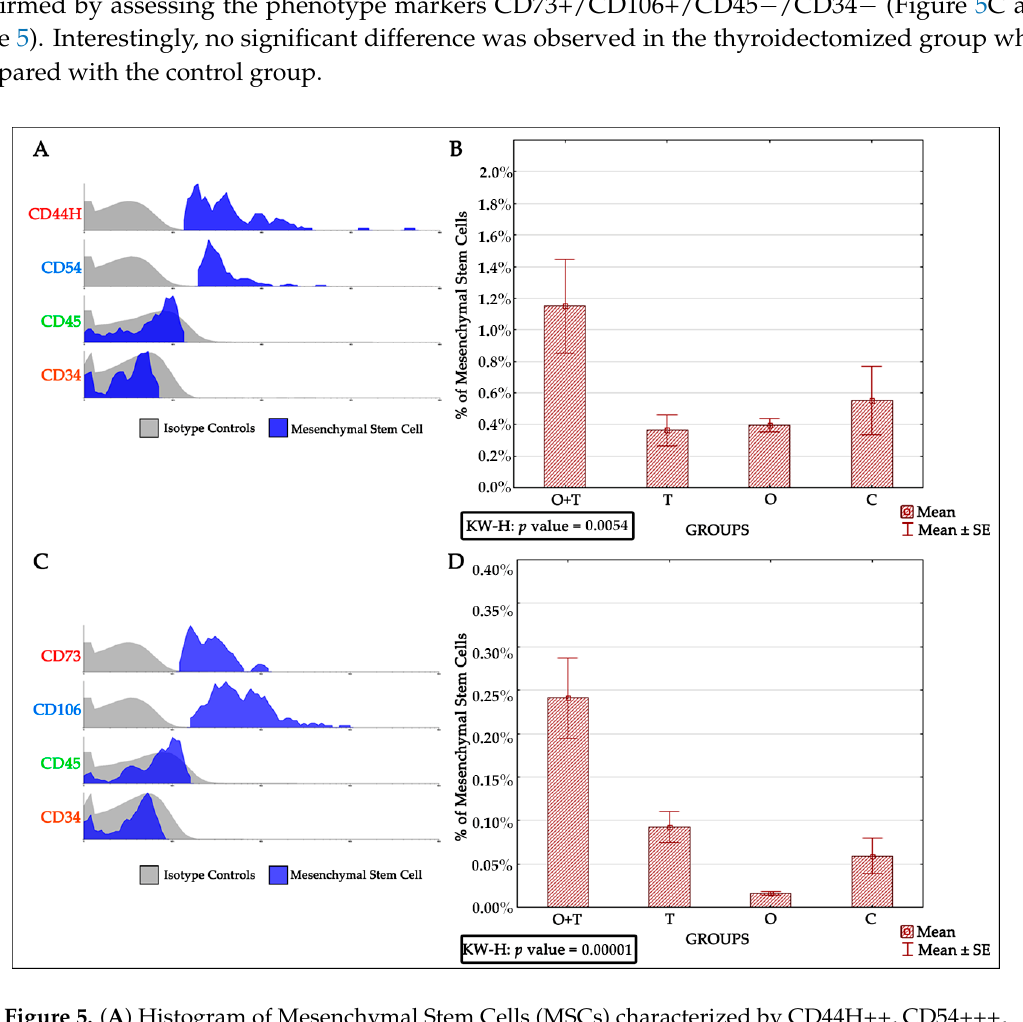
Table 3. Mann-Whitney post-hoc statistical test for the precursor B cells/Pro-B cells.